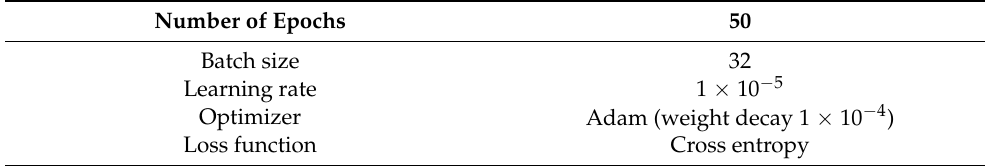
Table 2. Hyperparameters for the training.